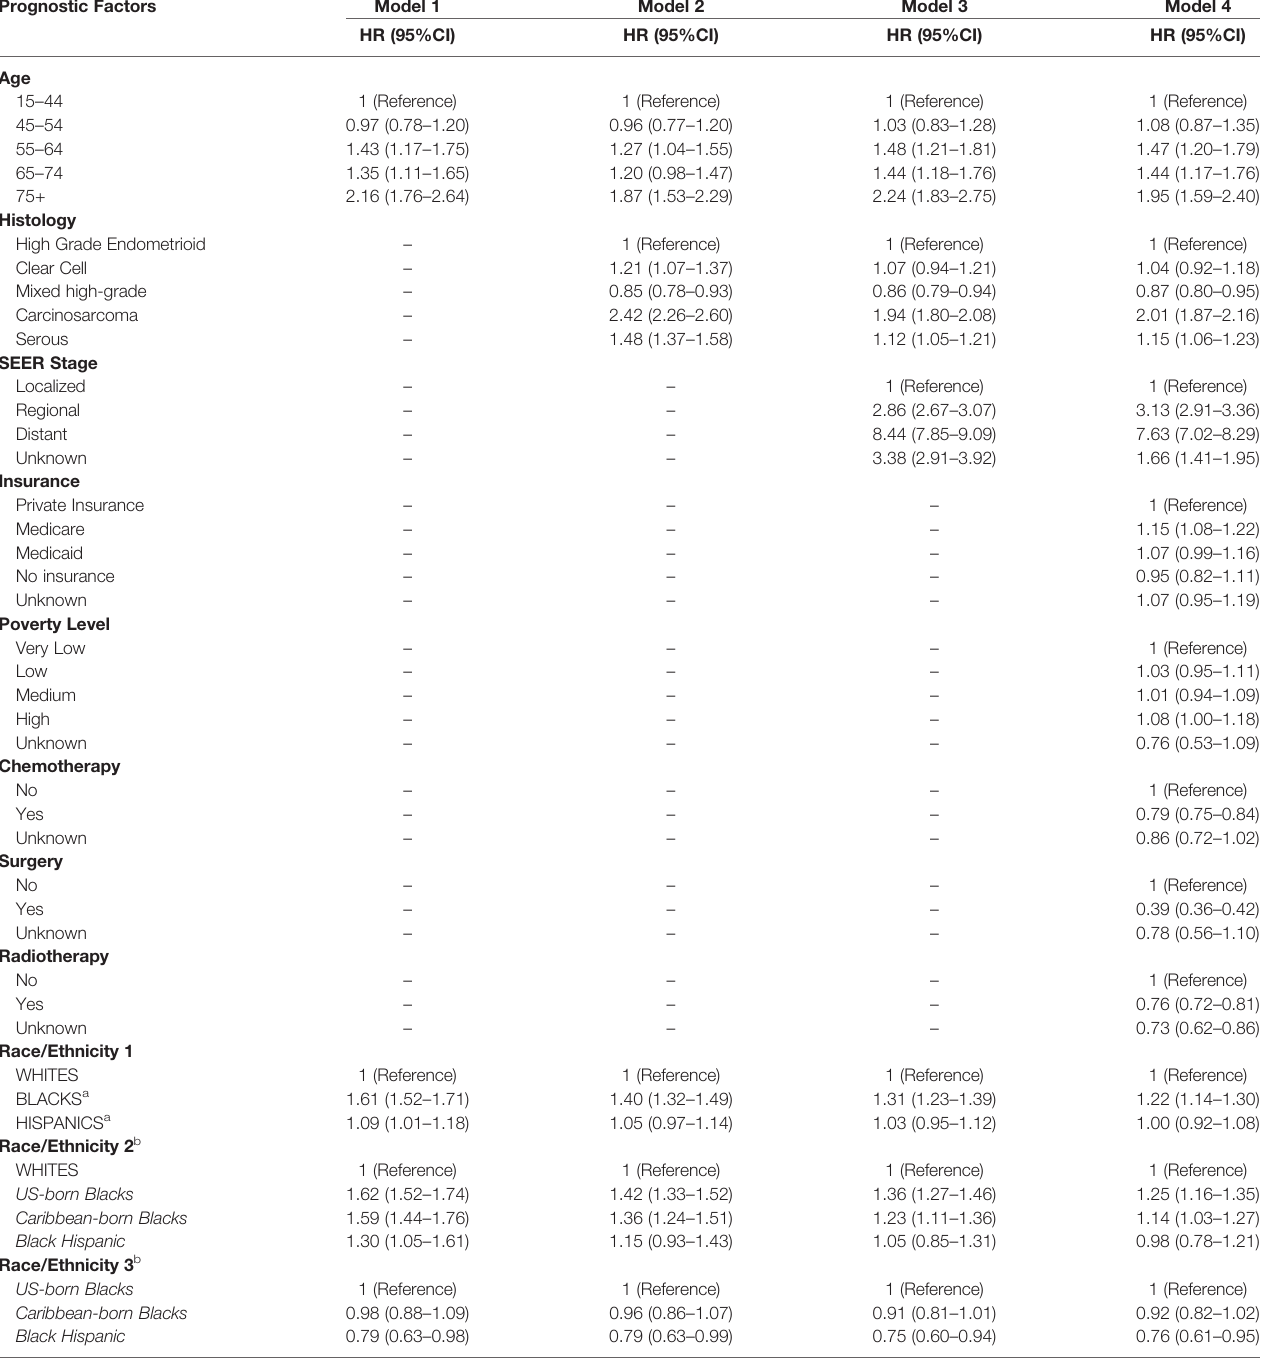
TABLE 3 | Hazard ratios (HR adjusted for state of residence) for demographic, social, and clinical determinants of Endometrial Cancer Type 2 survival in Florida and New York (2005 –